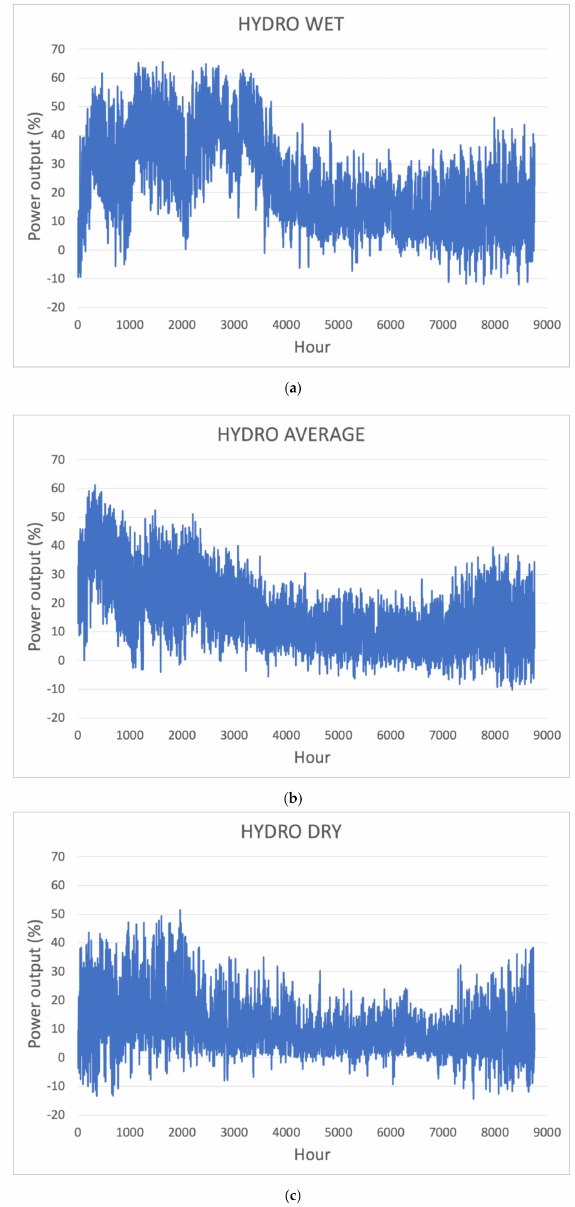
Figure 2. Hydro distribution profiles (hourly load diagrams): ( a ) wet profile; ( b ) average profile; ( c ) dry